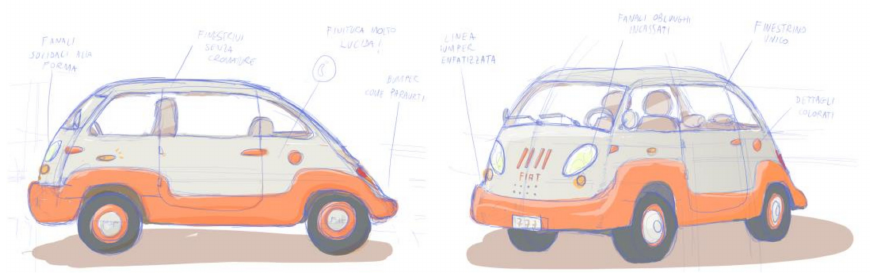
Figure 19. Sketches FIAT 600 Omega: Natural